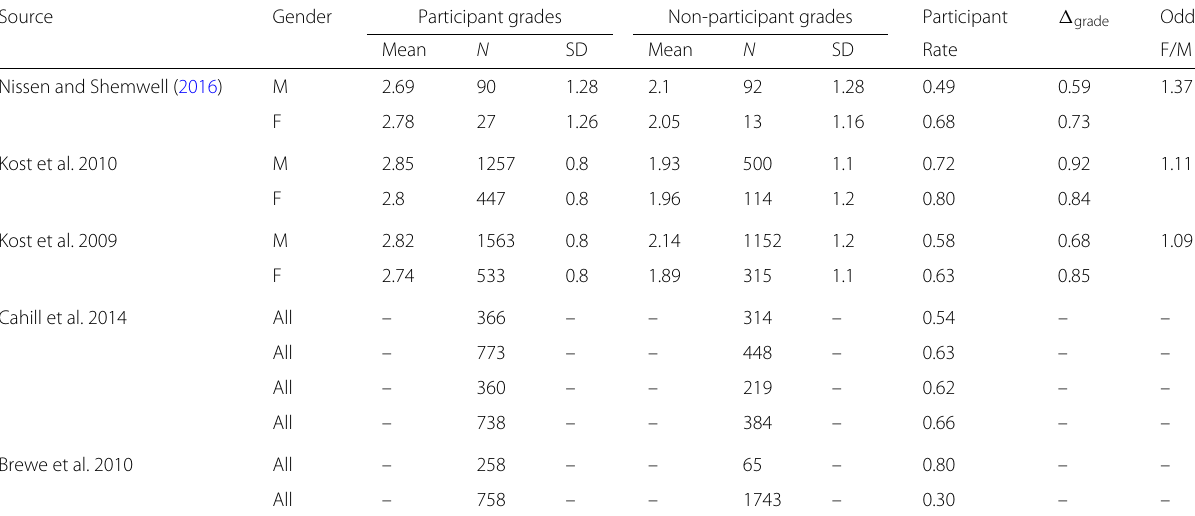
Table 1 Participation and GPA for students in previous studies Source Nissen and Shemwell